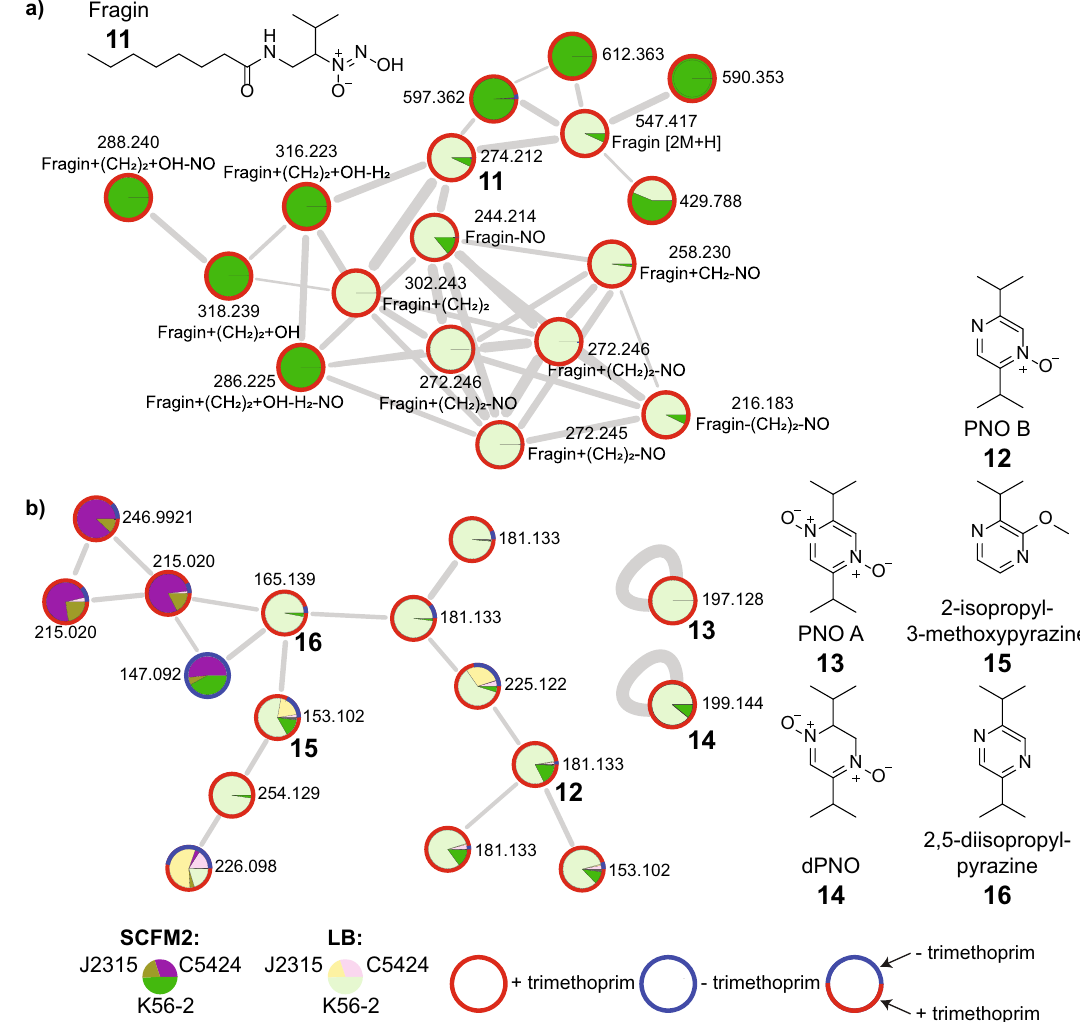
Figure 5. Distribution of fragin and pyrazine metabolites in SCFM2 and LB media. Pie charts on nodes correspond to relative abundance in strain and media condition. The coloring of node border represents whether the metabolite was detected only in the presence of trimethoprim (red border), only in the absence of trimethoprim (blue), or both in the presence or absence of trimethoprim (mixed color). A combination of blue and red border color shows total relative abundance of the metabolite in the absence or presence of trimethoprim, respectively across all strains. ( a ) Annotated fragin ( 11 ) cluster, which includes structural analogs and their in- source fragment ions which are characteristic of the diazeniumdiolate moiety. ( b ) Annotated nodes corresponding to pyrazines. The structures of pyrazine N -oxides PNO B ( 12 ), PNO A ( 13 ), dPNO ( 14